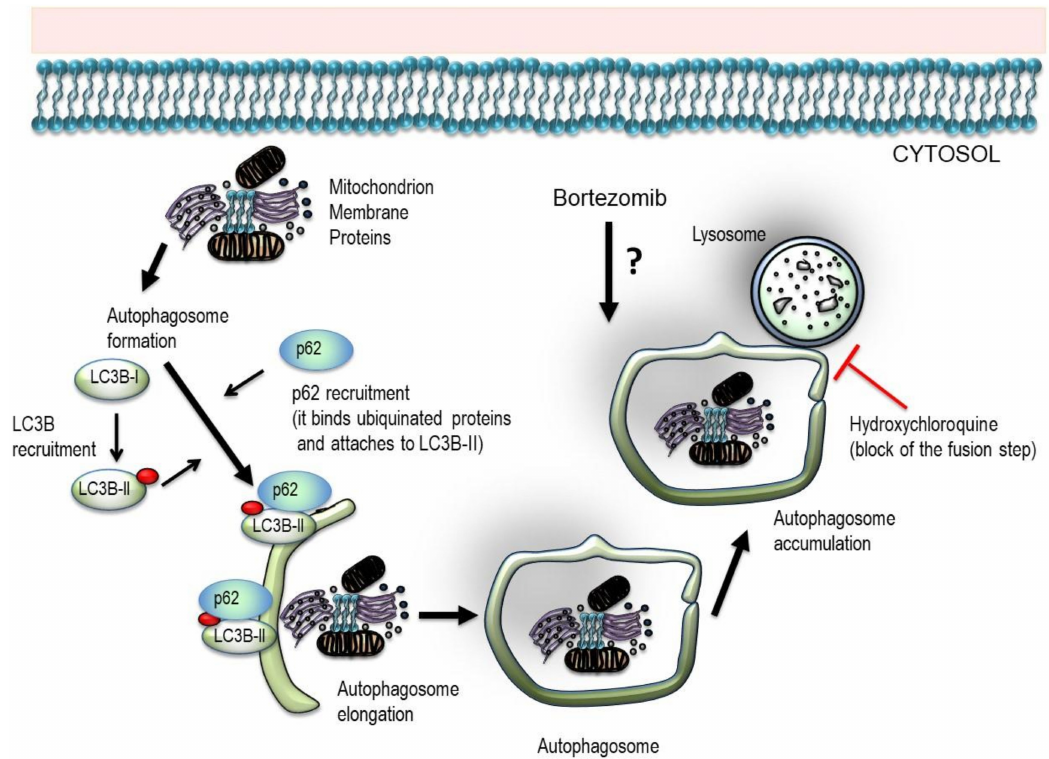
Figure 1. Schematic overview of the experimental design. Cytoplasmic cargo material including mitochondria, membrane, and unfolded proteins is engulfed by a double-membrane vesicle to form and elongate into an autophagosome. Autophagy related (ATG) proteins create two “ubiquitin-like conjugation systems” that catalyze the conversion of LC3B-I to its phosphatidylethanolamine (PE)-conjugated LC3B-II form. LC3B-II protein is recruited to the autophagosome and P62 along with the attached ubiquitinated proteins bind to LC3B-II protein. The complex LC3B-II-p62 is then incorporated into the autophagosome membrane, where it serves as a docking site of adaptor proteins and bound cargo. The mature autophagosome then fuses with the lysosome and forms an autolysosome, leading to cargo degradation and recycling of nutrients and metabolites. Hydroxychloroquine inhibits autophagosome–lysosome fusion and degradation. Thus, HCQ treatment promotes intracellular autophagosome accumulation that correlates with LC3B-II and p62